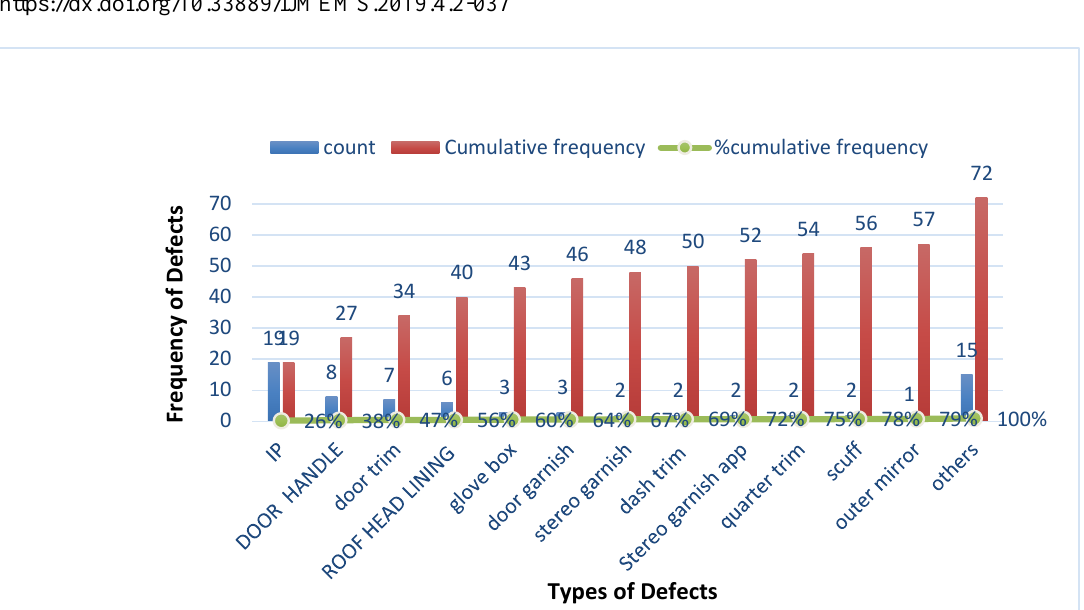
Figure 1. Frequency of defects